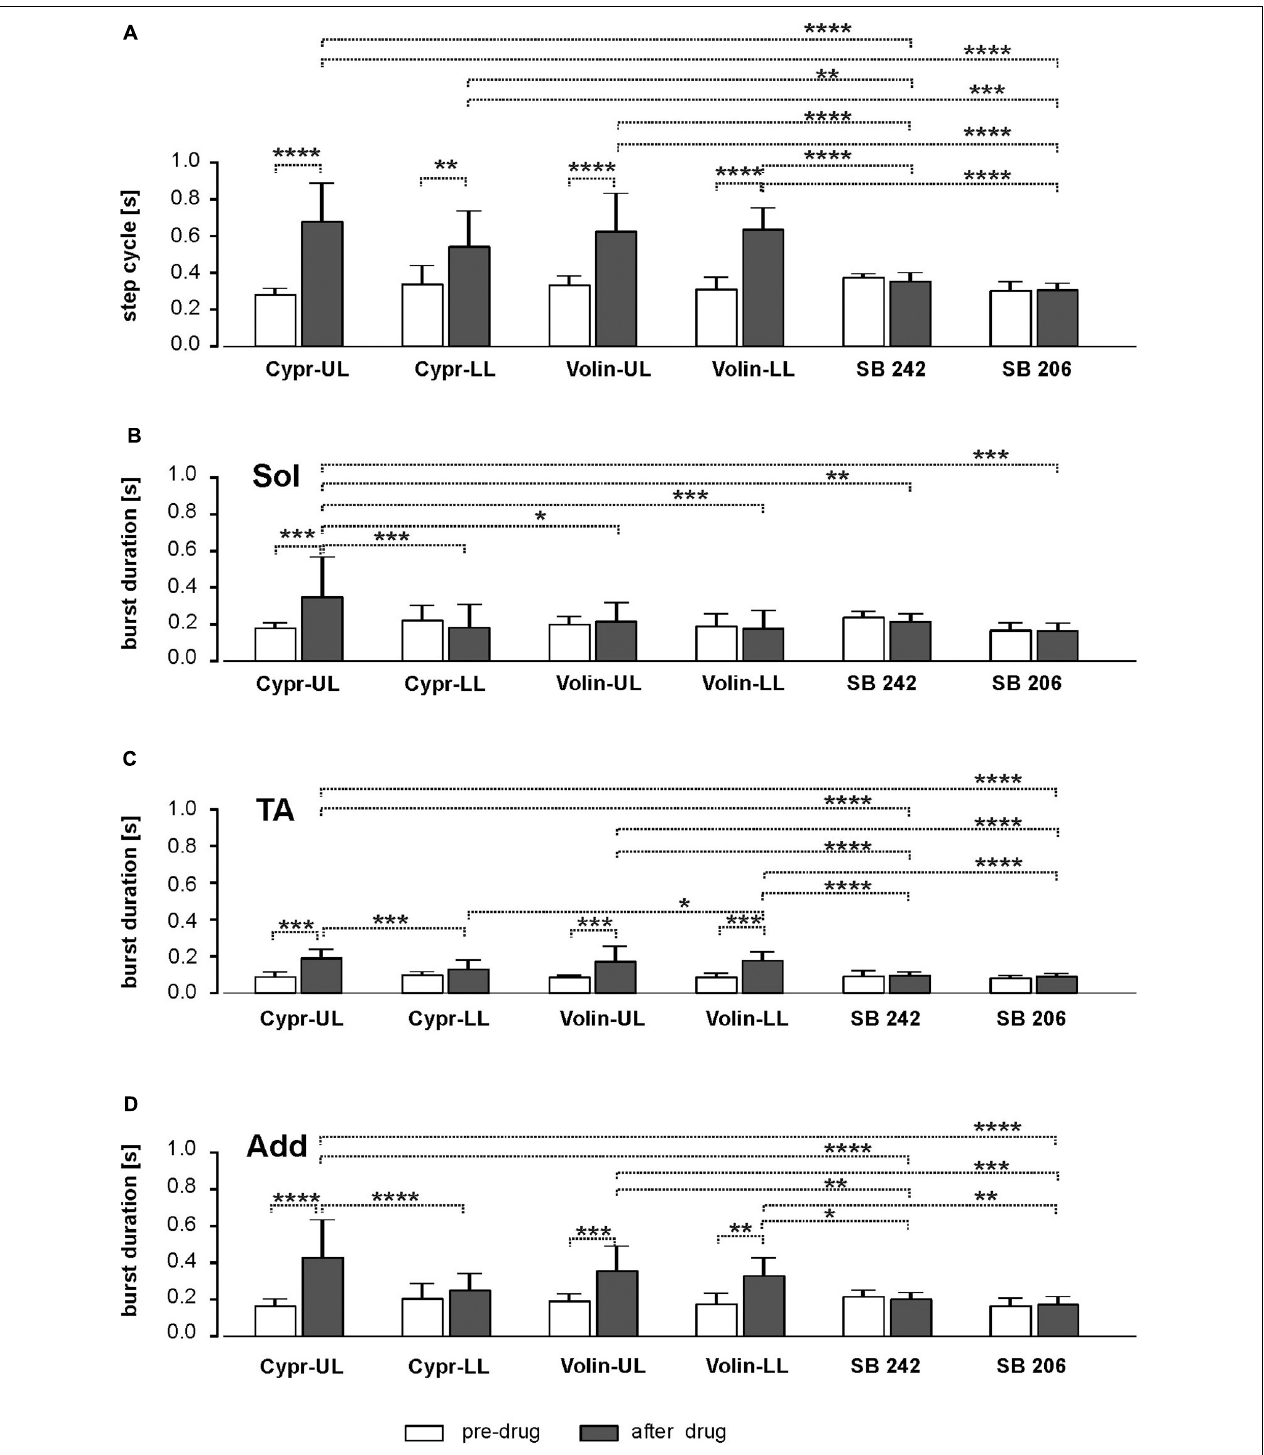
FIGURE 3 | Bar diagram presenting the cycle duration (A) and EMG burst duration of Sol (B) , TA (C) and Add (D) muscles before and after blockade of various 5-HT receptors by IT application of Cyproheptadine, Volinanserin, SB 242084 and SB 206553 in the upper lumbar (UL) or low lumbar (LL) spinal cord [mean ± Standard Deviation (SD)]. Results from left and right muscles were pooled in all the rats in the various experimental conditions, so the number of samples taken for analysis were: Cypr_UL n = 12, Cypr_LL n = 10, Volin_UL n = 10, Volin LL n = 10, SB 242 n = 12, SB 206 n = 10. Cypr, Cyproheptadine; Volin, Volinanserin; SB 242, SB 242084; SB 206, SB 206553; UL, upper lumbar spinal cord (L2/L3); LL, low lumbar spinal cord (L5/L6). The significance of the results was tested using ANOVA test followed by Sidak’s test for multiple comparisons (* p < 0.05, ** p < 0.01, *** p < 0.001, **** p < 0.0001).